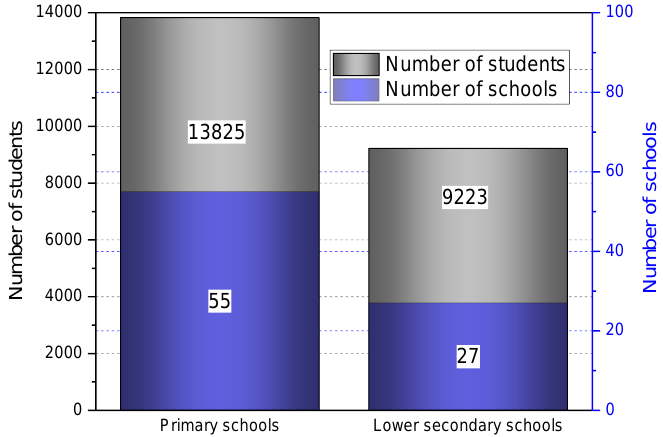
Figure 4. Number of schools and students in the municipality of Florence.